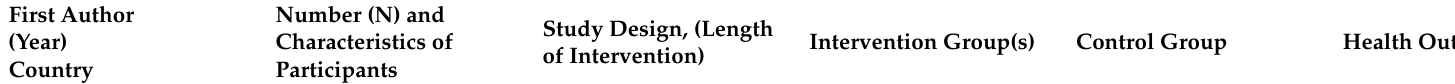
Table 2. Children’s health outcomes from nut